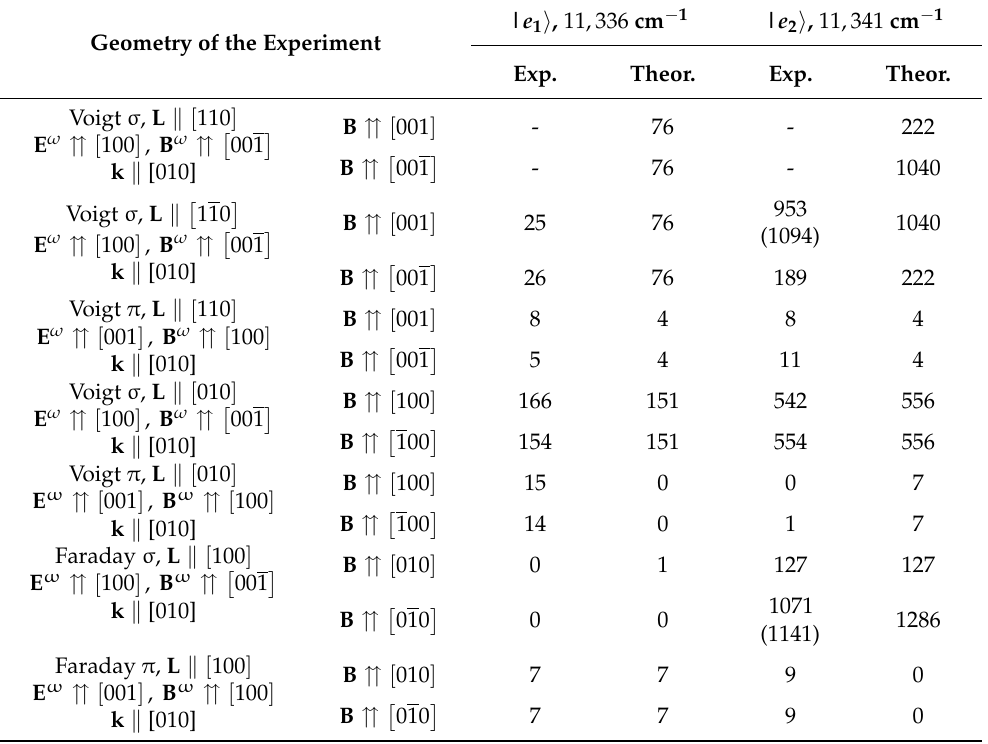
Table 2. Experimental (cm − 1 ) and theoretical (squares of matrix element moduli in relative units) values of the absorption coefficients at the maxima of two components of the lowest-frequency 4 b exciton line in the spectra of CuB 2 O 4 at T = 10 K in an external magnetic field | B | = 0.2 T. The relative units are chosen so that in the Faraday geometry for the 11,341 cm − 1 component at B (cid:20) [ 010 ] , (cid:2) (cid:3) L = S A 1 − S A 2 (cid:107) [ 100 ] , E ω (cid:20) [ 100 ] , B ω (cid:20) 001 the calculated value is numerically equal to the experimental